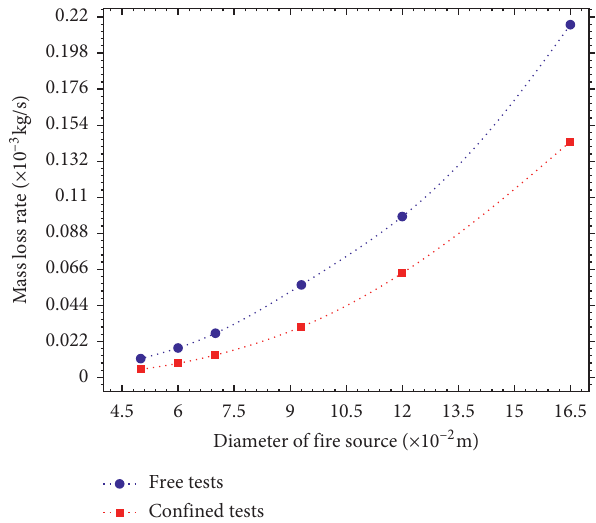
Figure 12: Variation of the mass loss rate of fuel in opened and confined surroundings.